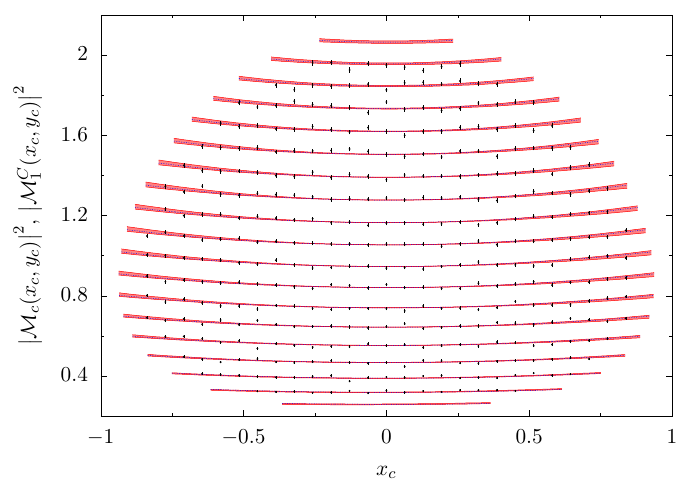
Figure 2 . Comparison of the dispersive Dalitz-plot distribution for η → π + π − π 0 to experimental data. The distributions are normalized to one at the Dalitz-plot center x bottom we depict slices through the Dalitz plot given for y min of ∆ y = 0 . 1 . We show the modulus square of the full amplitude |M c covering the statistical and systematical errors added in quadrature (red) as well as the central solution for the C -conserving part |M C provided by the KLOE-2 collaboration [25].